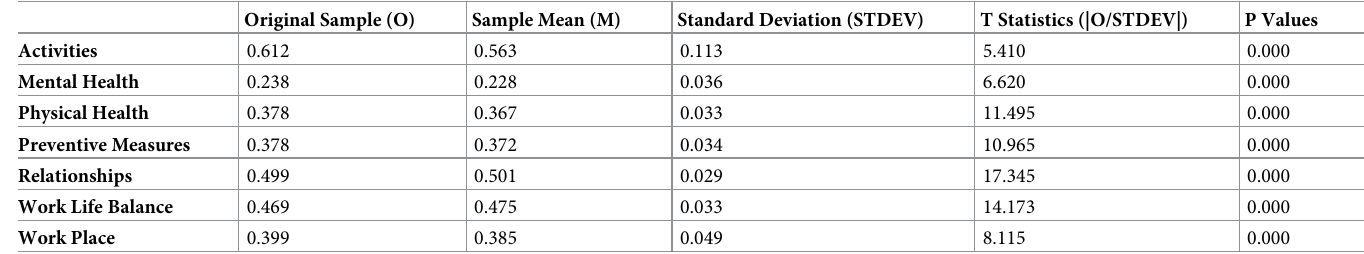
Table 6. AVE values of constructs, Bootstrapping with 2000